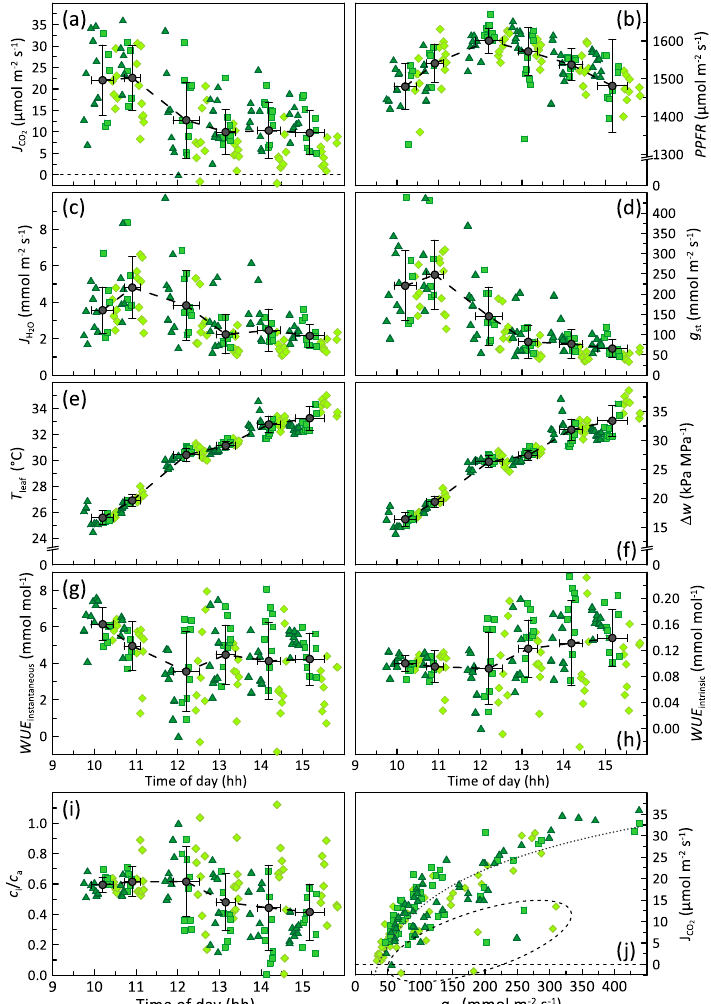
Figure 2. Diurnal variation of ( a ) net CO 2 exchange ( J CO2 ), ( b ) photosynthetic photon flux rates ( PPFR ), ( c ) transpiration ( J H2O ), ( d ) stomatal conductance for water vapor transfer ( g St ), ( e ) leaf temperature ( T leaf ), ( f ) water vapor partial pressure deficit ( Δ w), ( g ) instantaneous ( WUE inst ), ( h ) intrinsic water use efficiency ( WUE intrinsic ), ( i ) ratio of internal ( c i ) to ambient CO 2 molar fraction ( c a ) and ( j ) plot of J CO2 over g St of ‘Santhica 27’ leaves, measured on three (squares, triangles, diamonds) plots (0.5 m × 0.5 m) and the respective means (circles ± sd) from morning until afternoon. The dotted line in ( j ) reflects a power fit to all results except those assumed to be photoinhibited, while the dashed circle encloses data of obviously photoinhibited leaves. All measurements were performed 34 d after sowing and 4 d after slight rain (3 mm).